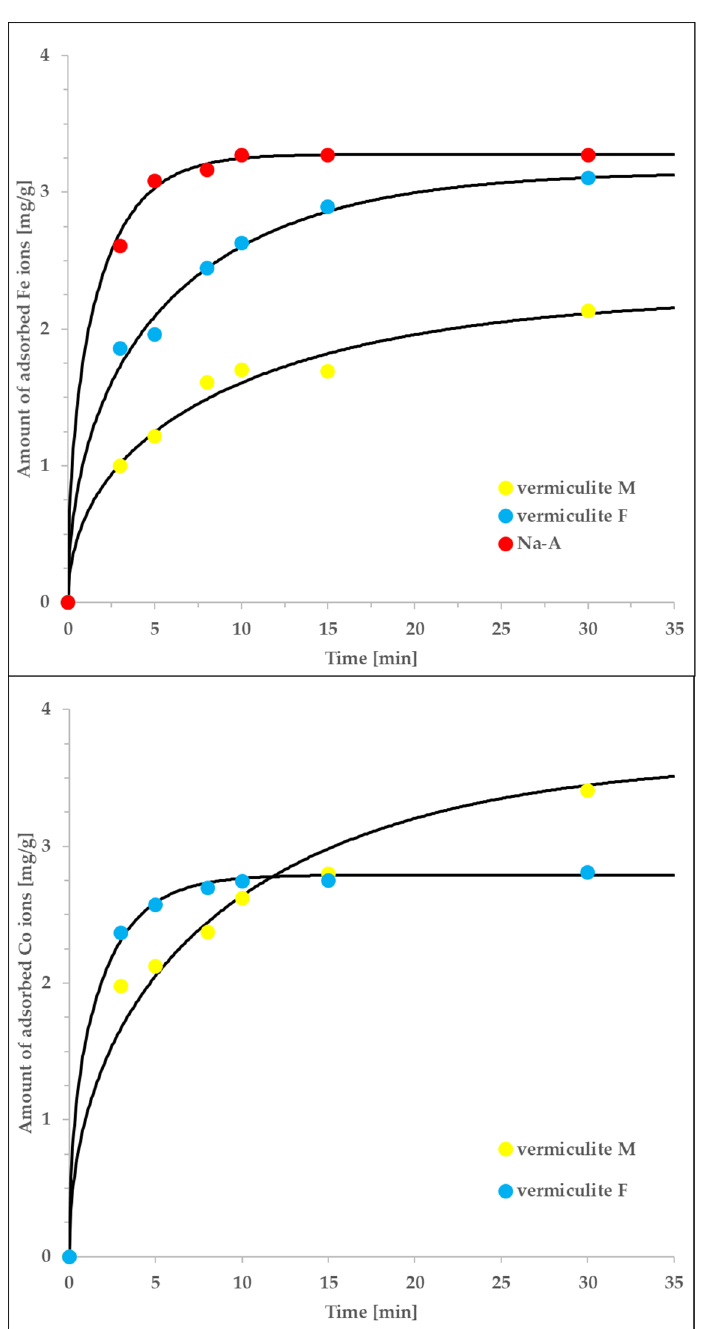
Figure 6. The agreement of the intraparticle pore-diffusion model (solid lines), with the non-equlibrium experimental data measured for vermiculite M, vermiculite F and Na-A interacting with either Co or Fe ions. The rest of the details is given in the main text.